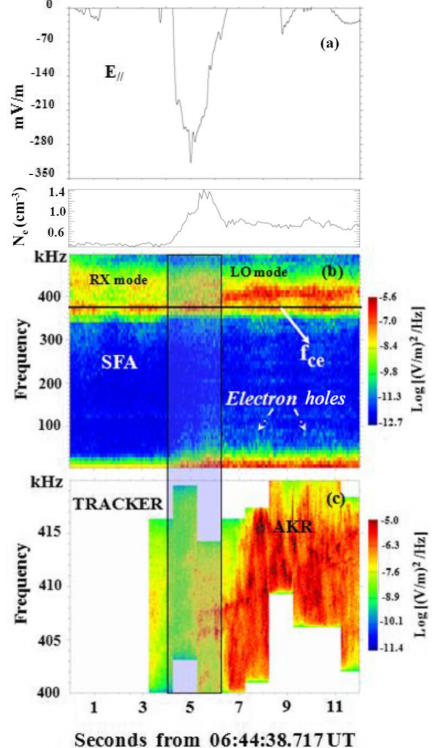
Figure 1. FAST spacecraft observations during the crossing of a localized double layer. The time duration is 12s. Panel (a) plots the parallel component of the anti-earthward-directed DC electric field together with the density variation. Panel (b) shows the electric power density as a function of frequency. The on-board sweep fre- quency analyser spans 0 to 500kHz, with a 4kHz bandwidth. The dark horizontal line is the non-relativistic electron gyrofrequency f ce . Panel (c) reveals the presence of large-amplitude fine spectral AKR features measured by the plasma tracker. The frequency axis is from 400 to 420kHz, with a 32Hz resolution. In (b, c) the shaded blue region is correlated with the crossing of the parallel electric